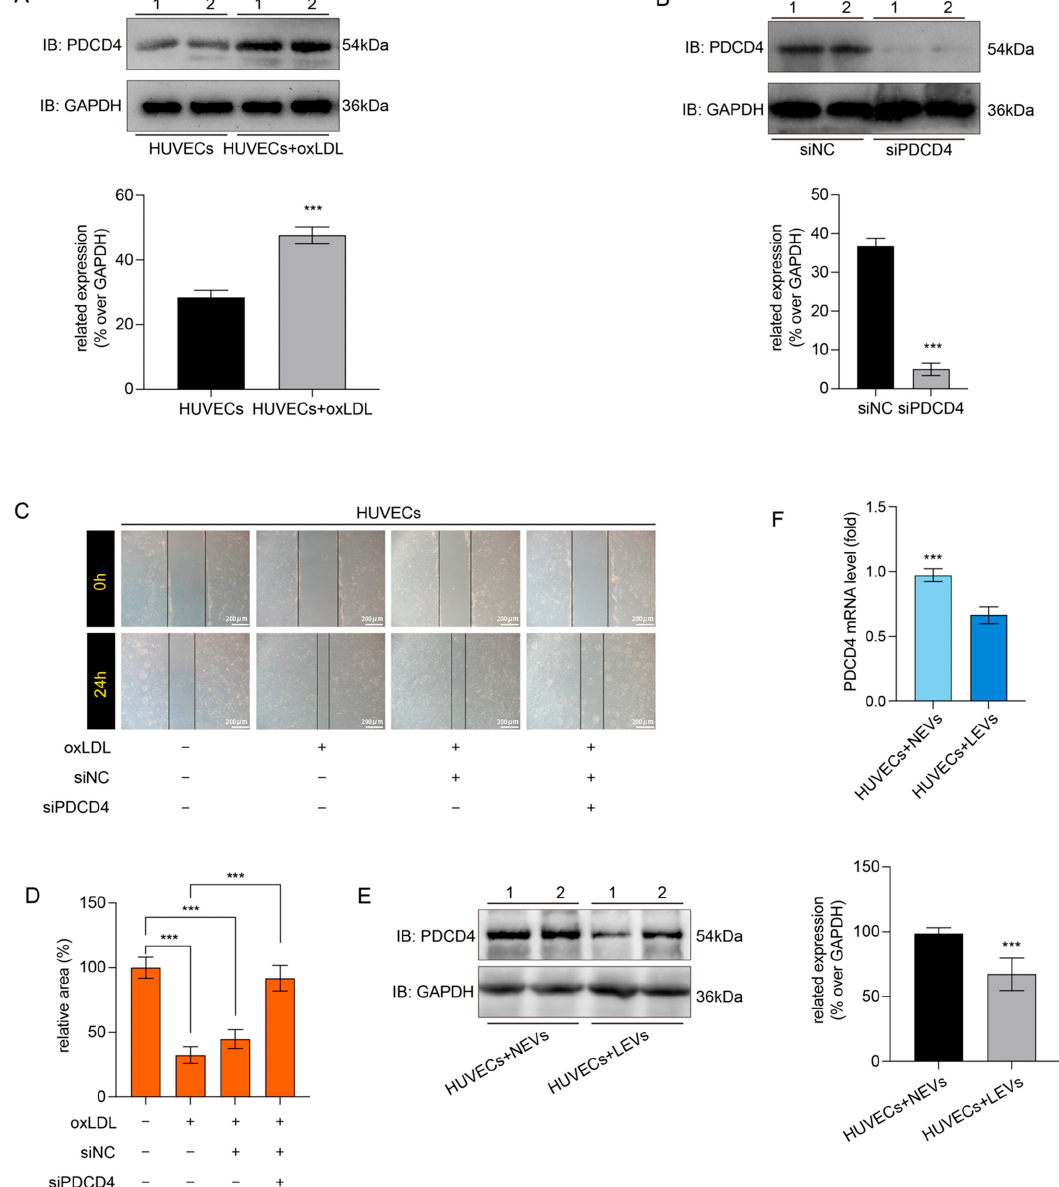
Figure 5. The EVs from LSW-induced VSMCs ameliorate the malignant migration of oxLDL-induced HUVECs by mediating the PDCD4 down-regulation. ( A ) The oxLDL increased the PDCD4 expression by a western blot analysis. The GAPDH was used as the loading control. The immunoblotting images were represented by densitometry as repetitive bands, *** p < 0.05. ( B ) The PDCD4 expression in the HUVECs with siRNA-PDCD4 (siPDCD4) or siRNA-negative control (siNC) was detected. The immunoblotting images were represented by densitometry as repetitive bands, *** p < 0.05. ( C ) The PDCD4 knockout reduced the malignant migration of oxLDL-induced HUVCEs via a wound-healing assay (100 × magnification, scale bar: 200 µ m). ( D ) The relative area of the wound healing scratch at 24 h was measured by ImageJ software, and the results of each treatment group were shown to the normal HUVECs without special treatment, *** p < 0.05. ( E ) The expression of PDCD4 in the HUVECs with NEVs or LEVs incubation. The immunoblotting images were represented by densitometry as repetitive bands, *** p < 0.05. ( F ) The mRNA expression of PDCD4 in the HUVECs with NEVs or LEVs incubation, *** p < 0.05. Results were presented as mean ± SD, n = 5 for each